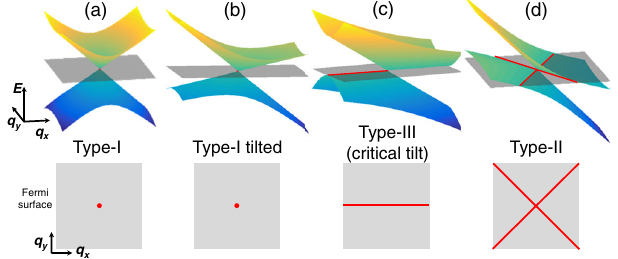
FIG. 1. Types of Dirac dispersions in two dimensions. (Top) Dispersions together with the zero-energy plane (grey). (Bottom, in red) Zero-energy Fermi surface. (a) Standard, type-I Dirac cones characterized by a linear dispersion in all directions in k space and a pointlike Fermi surface. (b) Type-I tilted Dirac cone. (c) Type-III Dirac point (critically tilted), combining flat band and linear dispersions. Its Fermi surface is a line. (d) Type-II Dirac